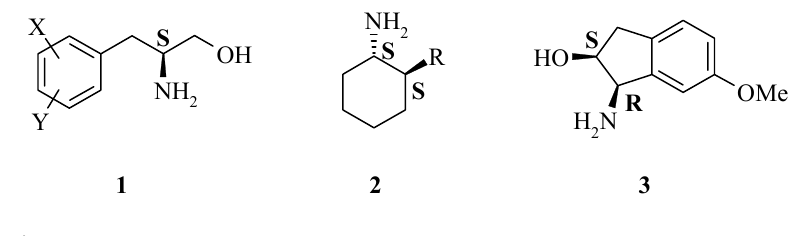
Figure 1 . Chiral